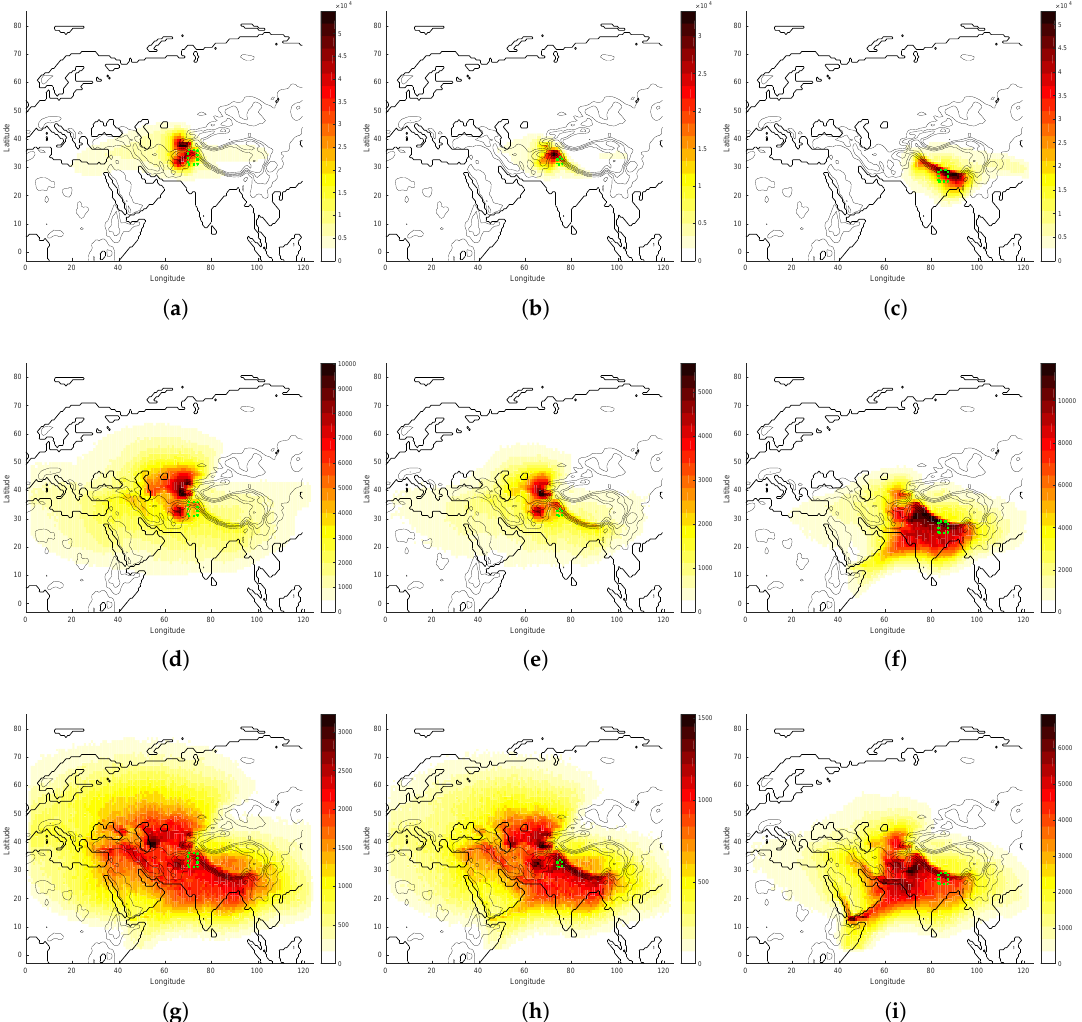
Figure 6. Summer (JJA) column integrated climatology (1980–2016), of the parcel density, for all parcels over each 1 ◦ area, originating from: ( a ) NP , 2 days back in time, along the parcel trajectory; ( b ) U , 2 days back in time, along the parcel trajectory; ( c ) K , 2 days back in time, along the parcel trajectory; ( d ) NP , 6 days back in time, along the parcel trajectory; ( e ) U , 6 days back in time, along the parcel trajectory; ( f ) K , 6 days back in time, along the parcel trajectory; ( g ) NP , 10 days back in time, along the parcel trajectory; ( h ) U , 10 days back in time, along the parcel trajectory; ( i ) K , 10 days back in time, along the parcel trajectory. The area of interest is illustrated by a green dashed box. If it is assumed that 36 ◦ is the dividing line between the tropics and extra-tropical regions and the number of parcels in each region is measured, we can obtain a rough measure of the relative influence of the extratropics on our regions of interest. From the 10-day back-trajectories, we measure that approximately 45%, 41%, and 20% of parcels originate from the extratropics for NP , U , and K ,